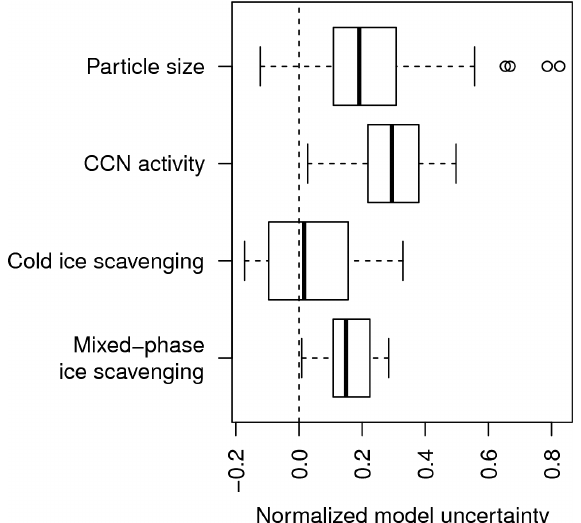
Fig. 7. Boxplot of the distributions of normalized model uncer- tainties for particle size, CCN activity, and the LIM MIXED and LIM COLD tests of the ice scavenging parameterization. Thick central lines show the median; box extent shows the 25-%ile to 75- %ile; whiskers extend up to 1.5 times the length of the box, or to the most extreme point; and dots show outliers beyond the whiskers.